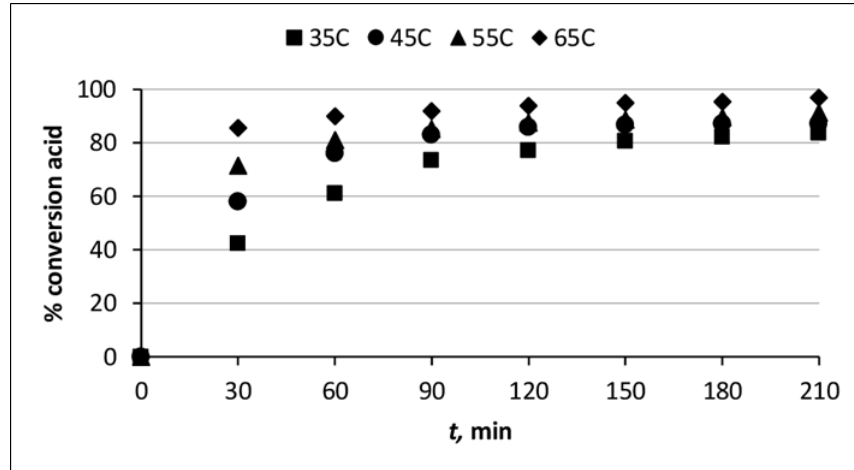
Figure 5. Influence of temperature on the conversion of propanoic acid into propyl propanoate. Conditions: acid/ alcohol/catalyst (H